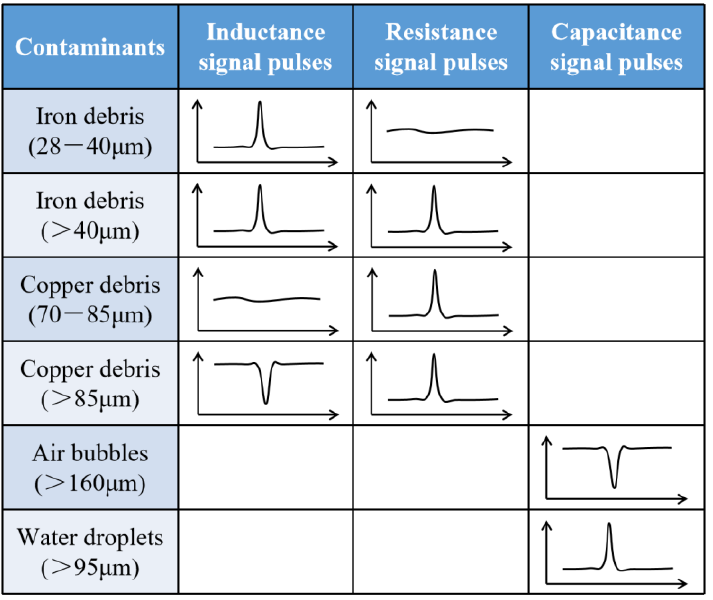
Figure 13. Signal pulse characteristics of contaminants with different sizes.